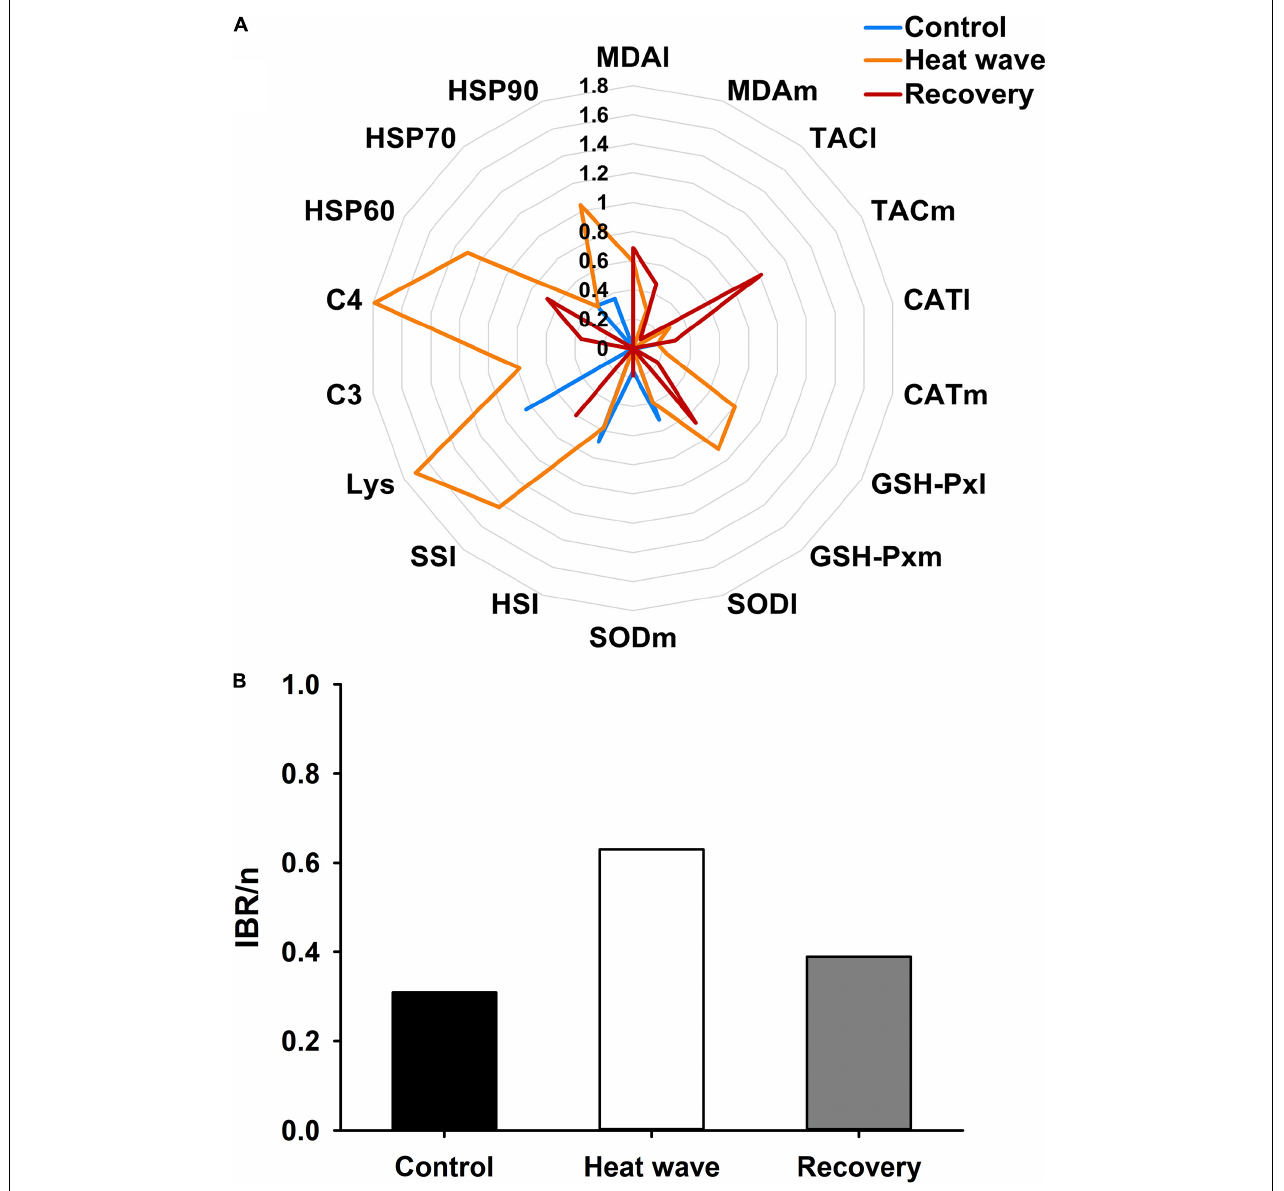
FIGURE 6 | Integrated biomarker response (IBR) star plot (A) , and IBR/n values (B) for Mauremys mutica after thermal treatments. MDAl, MDA in liver; MDAm, MDA in muscle; TACl:TAC in liver; TACm:TAC in muscle; CATl, CAT in liver; CATm, CAT in muscle; SH-Pxl, GSH-Px in liver; GSH-Pxm, GSH-Px in muscle; SODl, SOD in liver; SODm, SOD in muscle; HIS, hepatosomatic somatic indices; SSI, spleen somatic indices; Lys,